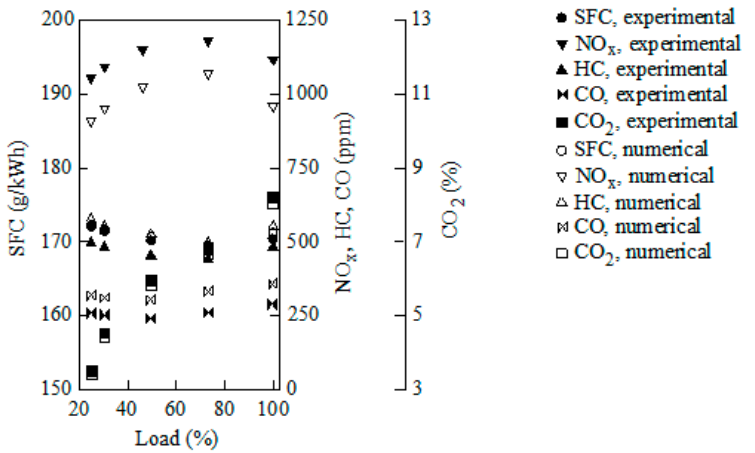
Figure 1. Specific fuel consumption (SFC) and emissions numerically and experimentally obtained at different loads.